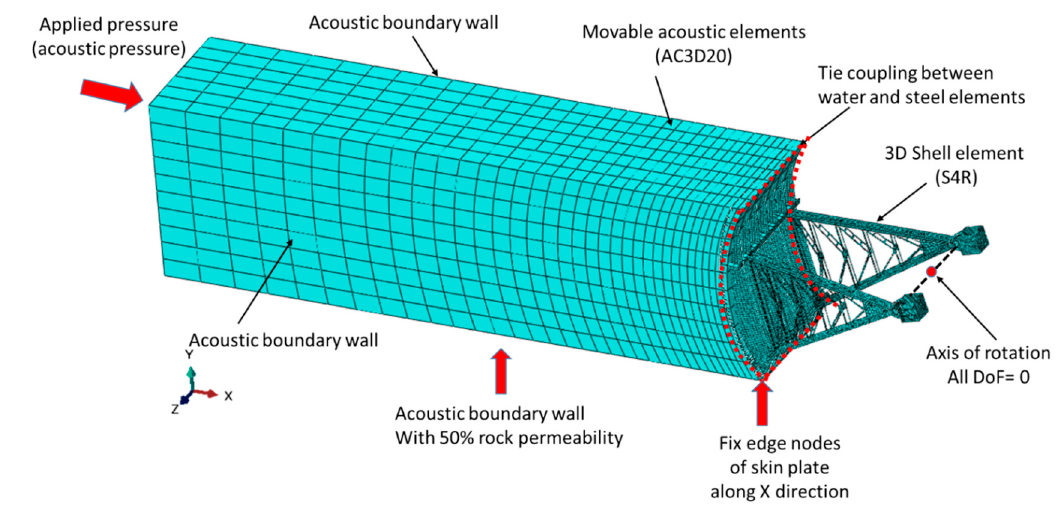
Figure 9. The coupled acoustic–structure finite element model of the slipway gateway.